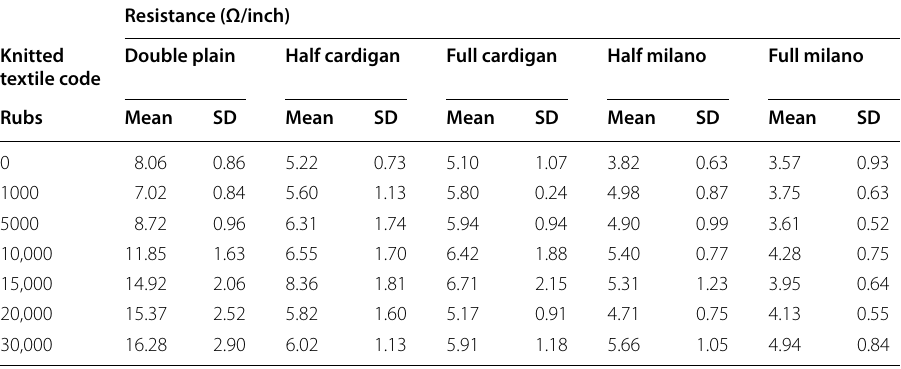
Table 5 The resistance values (unit: Ω) of the five knitted textiles before and after abrasions from 1000, 5000, 10,000, 15,000, 20,000 and 30,000 rubs Resistance (Ω/inch) Double plain Knitted textile code